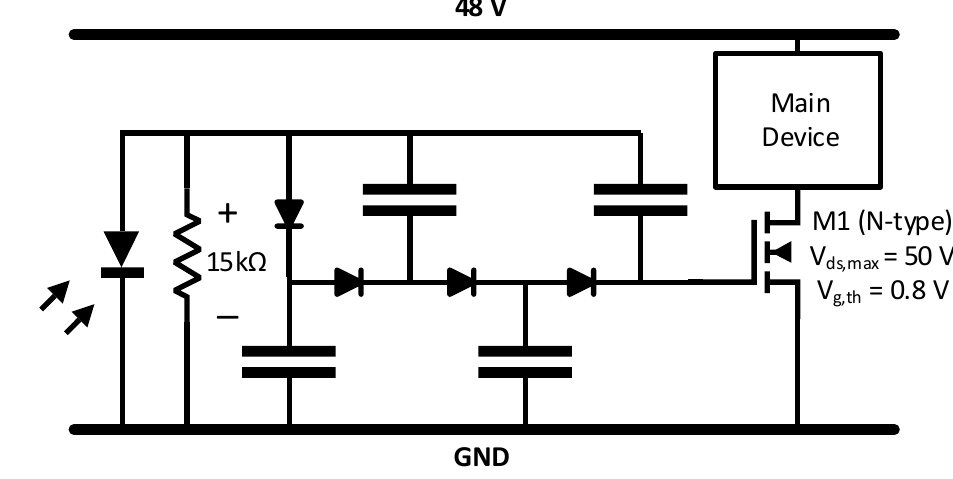
Figure 8. Laser standby solution with a four-stage Dickson charge pump attached to an NMOS footer switch M1. This design differs in several minor ways from the traditional passive Dickson design in Figure 7. The photodiode output does not swing negative, which necessitates a diode at the positive input. In addition, the gate of M1 is attached to a flying capacitor to avoid an unnecessary diode drop. This technique will only work if the main device can latch the gate of M1 quicker than 1